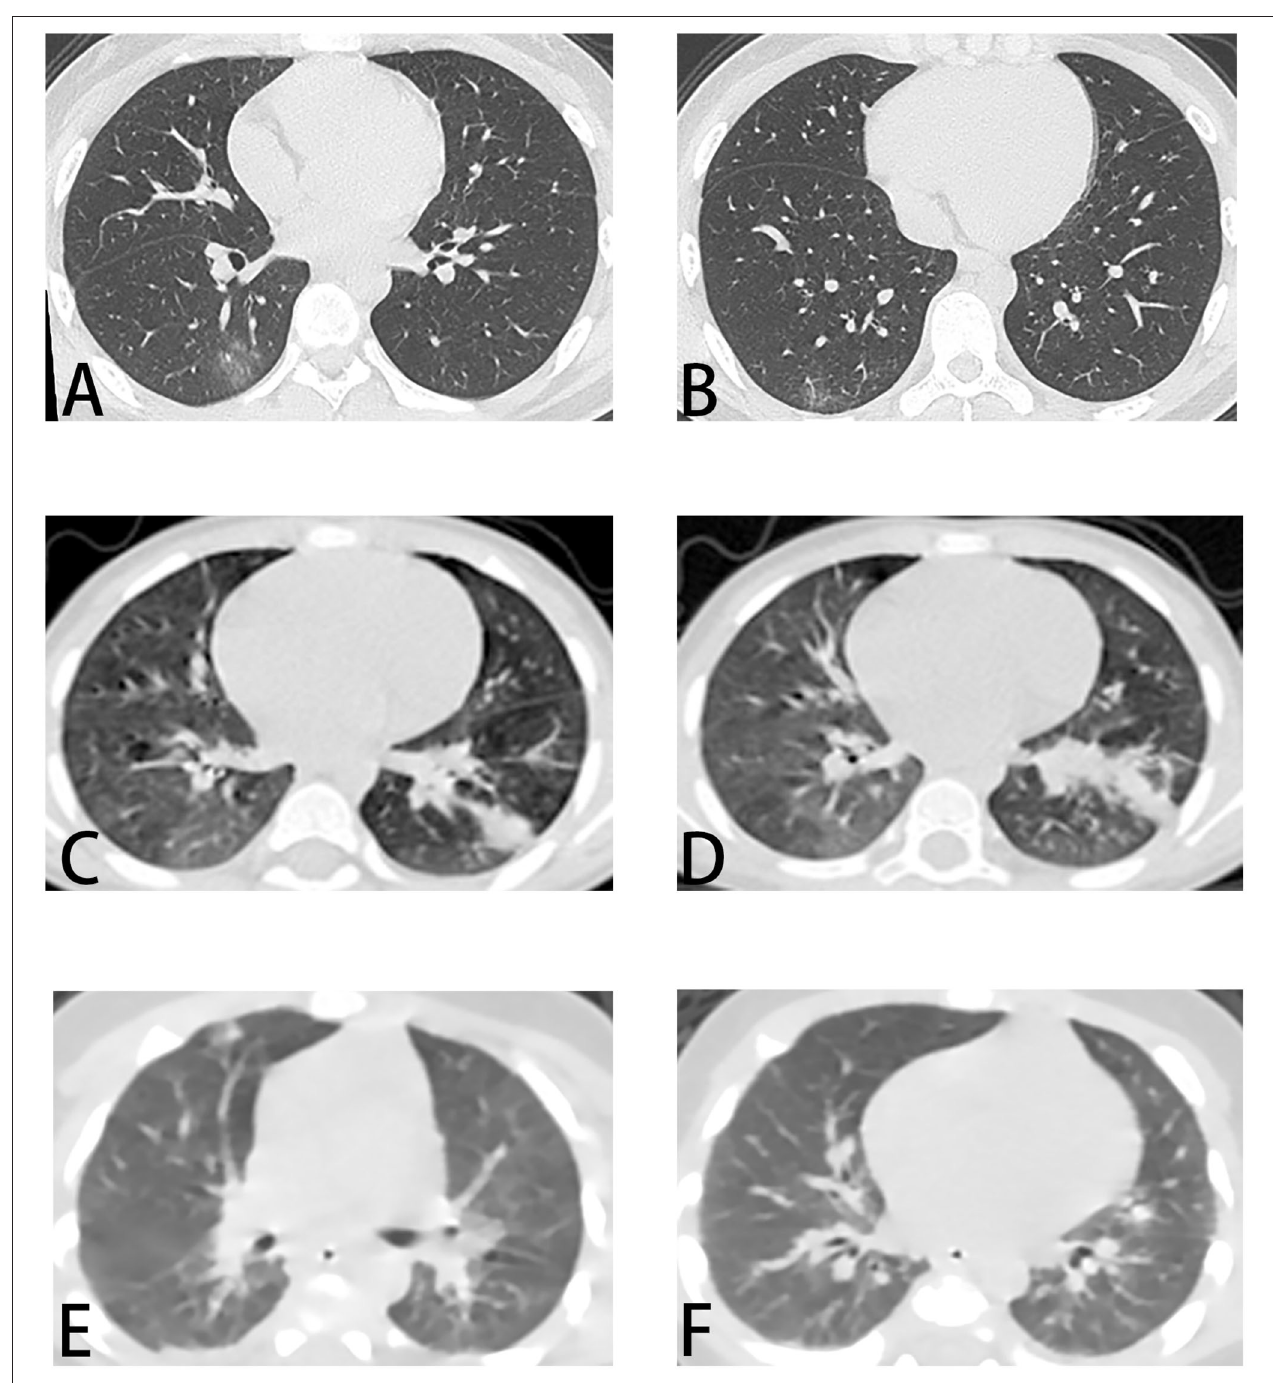
FIGURE 2 | Chest CT images of patients. (A,B) COVID-19. Male, 15 years old. On admission, chest CT showed ground-glass opacities in the inferior lobe of the right lung. (C,D) Mycoplasma pneumonia. Male, 4 years old. Chest CT showed bilateral lesions with consolidation in inferior lobe of the left lung. (E,F) Other viral pneumonia (respiratory syncytial virus). Male, 1 month old. Chest CT showed diffused consolidations in both lungs. CT, computed tomography.